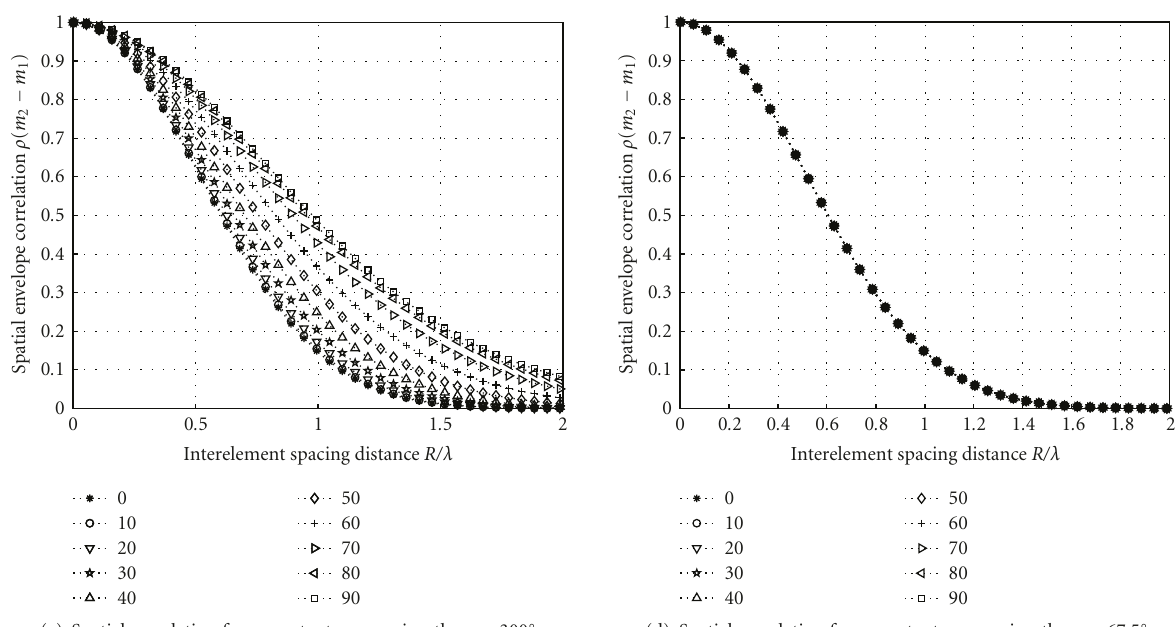
Figure 1: Spatial correlation between 2 elements located at 45 ◦ and 90 ◦ , respectively. Elevation is varied from ϑ o = 0 ◦ to 90 ◦ . This assessment also includes multiple mean azimuthal angles for a given value of the concentration parameter κ =